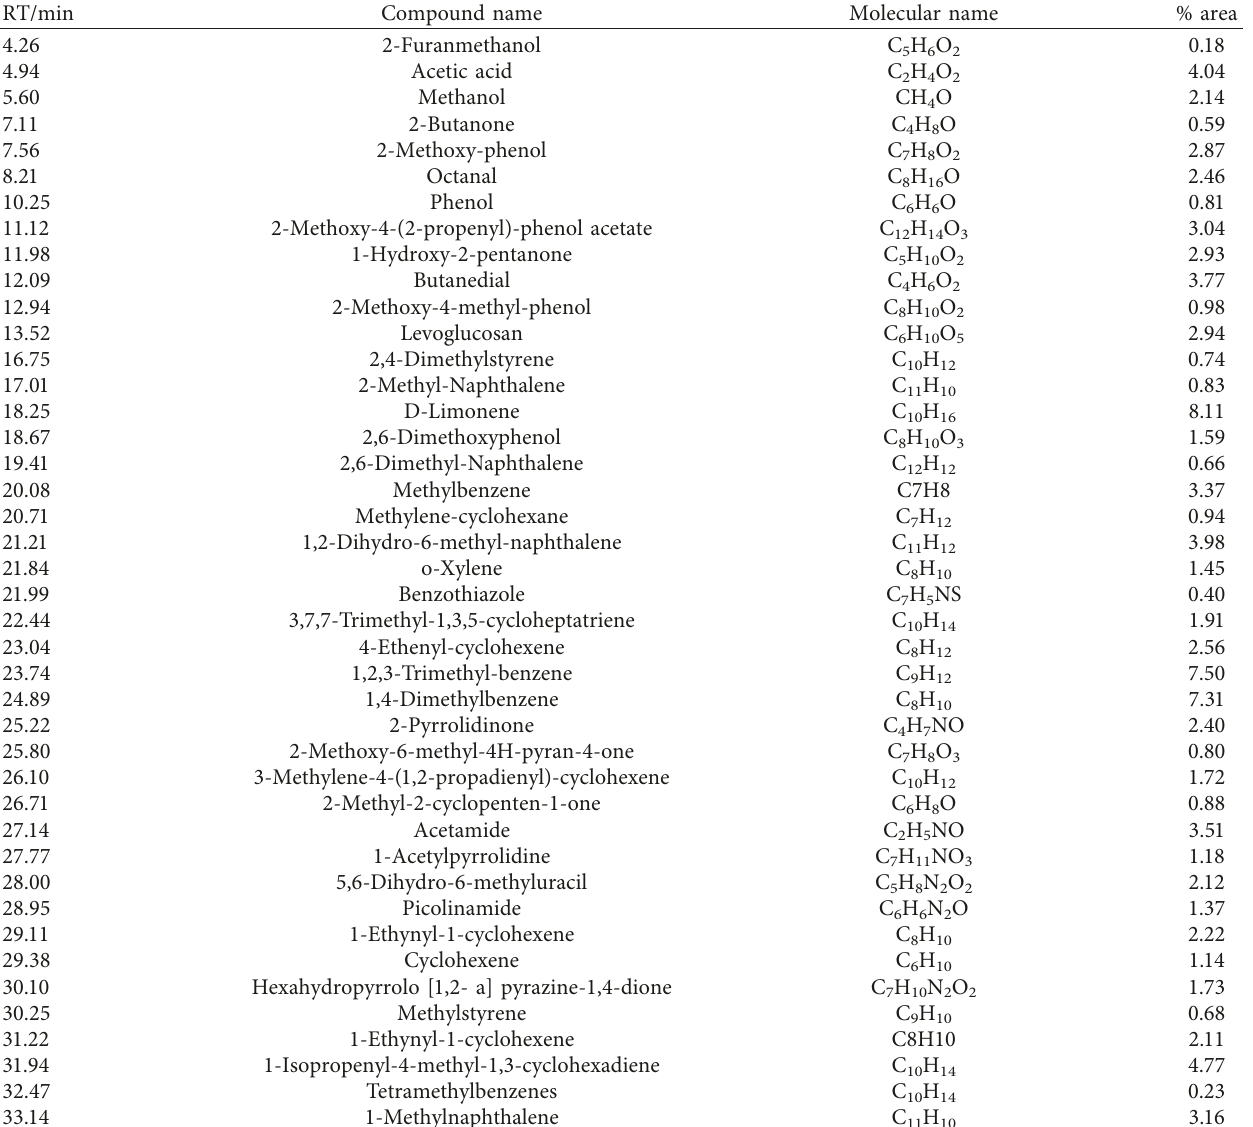
Table 3: GC-MS analysis of